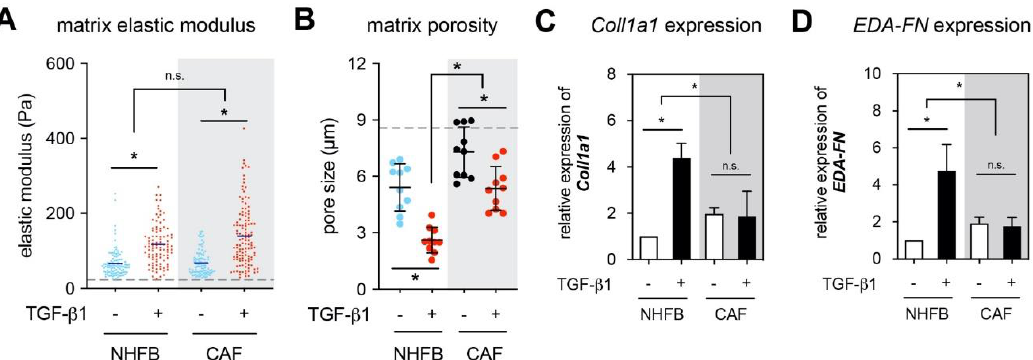
Figure 2. Matrix remodeling of NHFB and CAF in the presence and absence of TGF- β 1. Collagen matrices were decellularized and analyzed regarding ( A ) matrix elastic modulus and ( B ) mean pore size. For both ( A ) and ( B ) the dashed line symbolizes empty collagen matrix pore size without cells. The relative gene expression of ( C ) alpha 1 chain of collagen type 1 ( Coll1a1 ) and ( D ) fibronectin containing EDA-domain ( EDA-FN ) were analyzed using qPCR and were normalized to NHFB cultured in the absence of TGF- β 1. Data are represented as mean ± SD; *—significance level of p < 0.05; n.s.—not significant. All quantitative experiments were performed at least in 3 replicates using fibroblasts and CAF from 3 different donors for each condition.